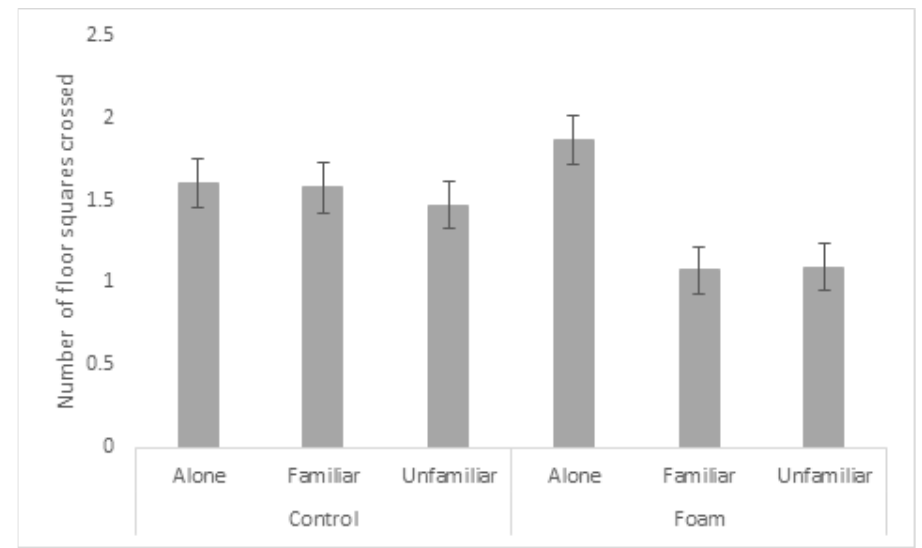
Figure 2. Activity within the foam box described by mean number of floor squares crossed by pigs in the six foam and control treatments. Values given are least squares mean (LSM) ± standard error (SE). Lack of overlap of SE error bars indicates significant pairwise differences ( p < 0.05) between treatments. Overall p -value for the interaction: p < 0.001.